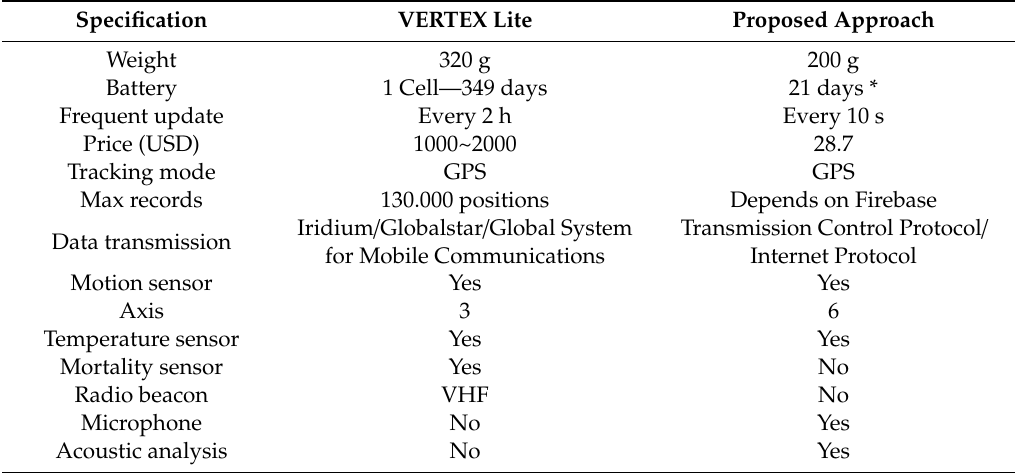
Table 3. Comparative results between the proposed approach and a currently available